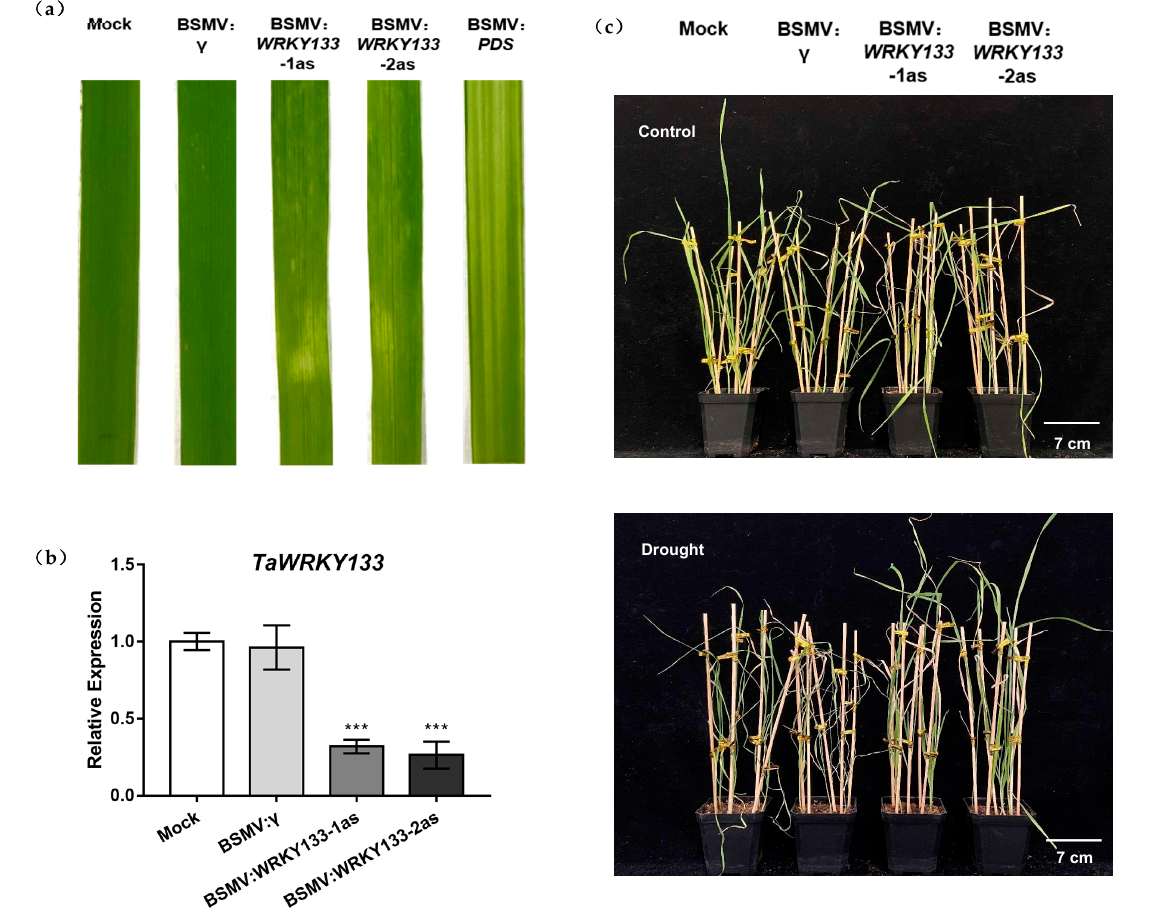
Figure 8. Silencing efficiency of TaWRKY133 in wheat and the phenotype of gene − silenced wheat under 10 d of drought treatment. ( a ) Phenotype of TaWRKY133 gene-silenced wheat leaves after inoculation. ( b ) Silencing efficiency of TaWRKY133 in gene-silenced wheat. ( c ) Phenotype of TaWRKY133 gene-silenced wheat under 10 d of drought stress. Asterisks indicate significant differences (*** p < 0.001). No asterisk means non-significant difference.